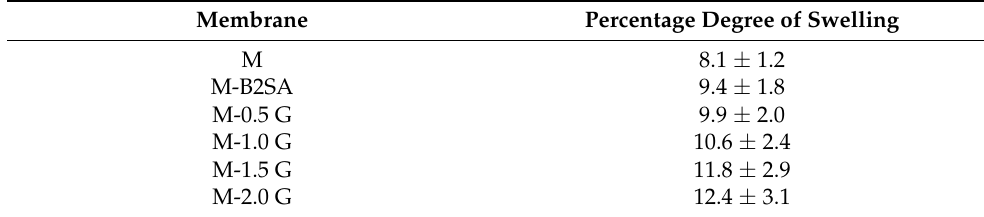
Table 3. The percentage degree of swelling of the developed